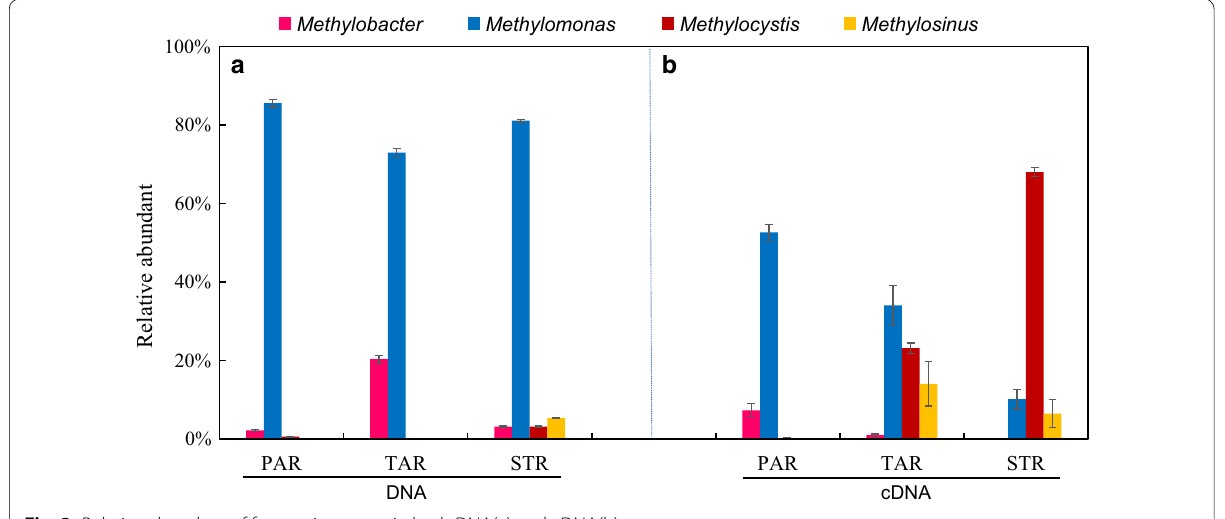
Fig. 3 Relative abundant of four main genera in both DNA(a) and